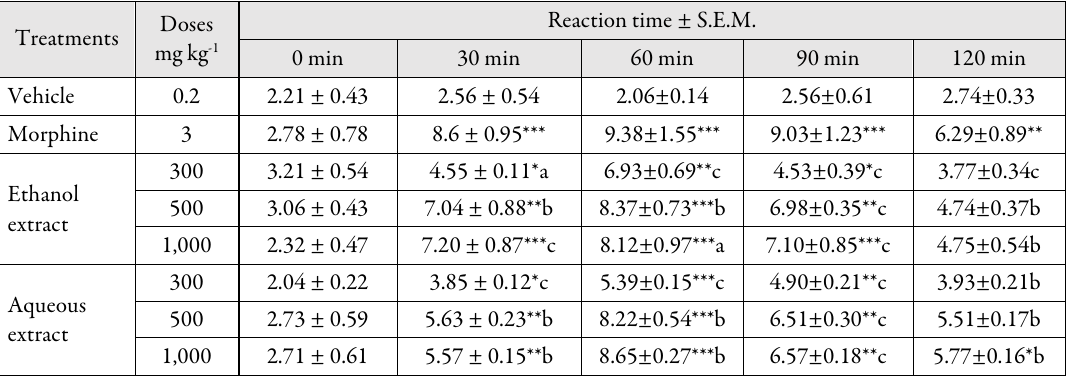
Table 1. Analgesic effect of aqueous and organic extracts of O. ficus-indica flower, latency in tail flick test